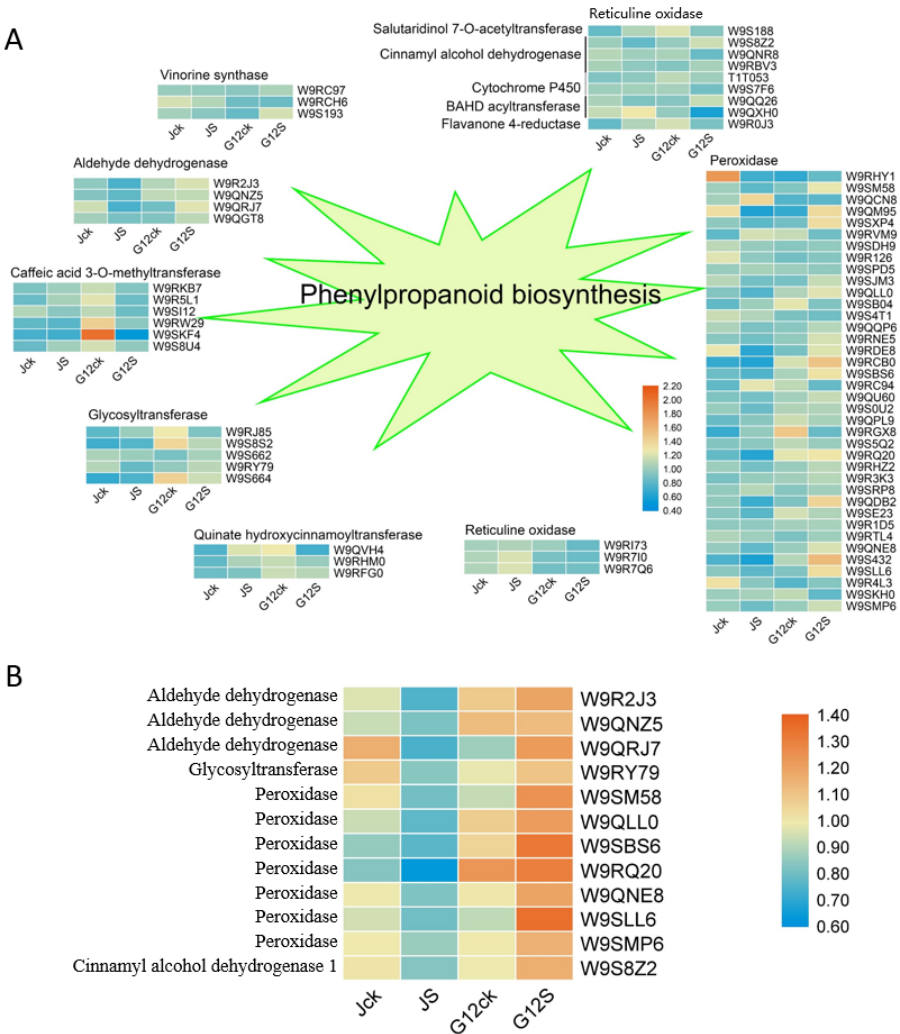
Figure 5. Heatmap of proteins involved in phenylpropanoid biosynthesis pathway. ( A ) Heatmap of proteins identified in phenylpropanoid biosynthesis pathway. ( B ) Heatmap of DRPs involved in phenylpropanoid biosynthesis pathway. Red represents a high gene expression level and blue represents a low gene expression